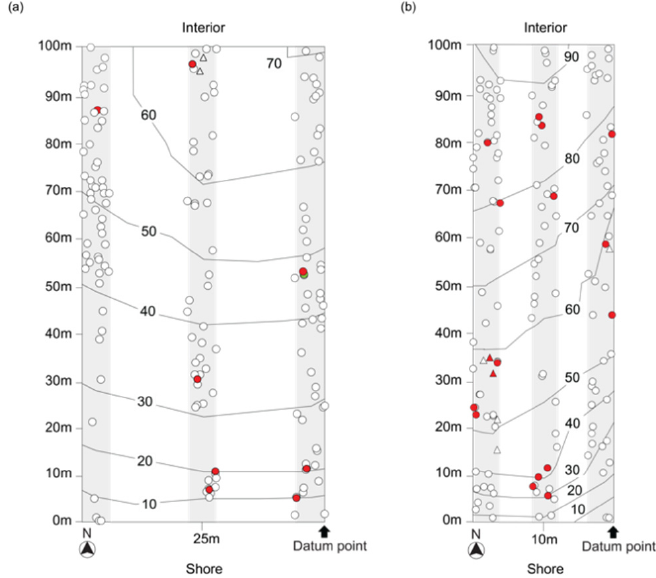
Figure 3. Distribution of trees in the six belt transects (grey bands) in 8–9-year-old ( a ) and 10-year-old ( b ) plantations, with the contour lines representing the topographic gradient denoting relative elevation to the datum point; symbols represent mangrove tree species, such as A. alba (O) and R. mucronata ( ∆ ); the red symbols represent dead trees and the green symbols represent newly recruited trees.